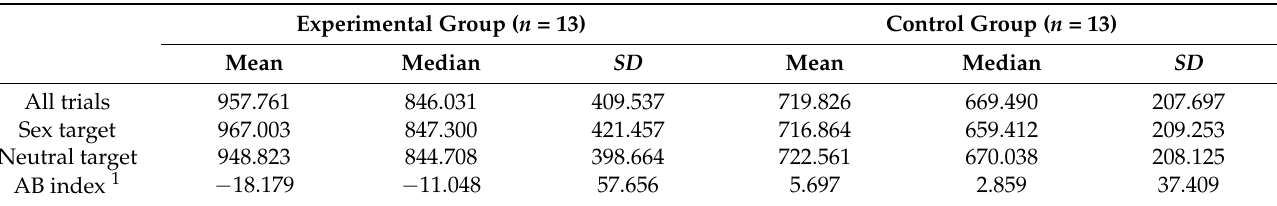
Table 1. Dot-probe task: Mean RT (ms), median, and SD .